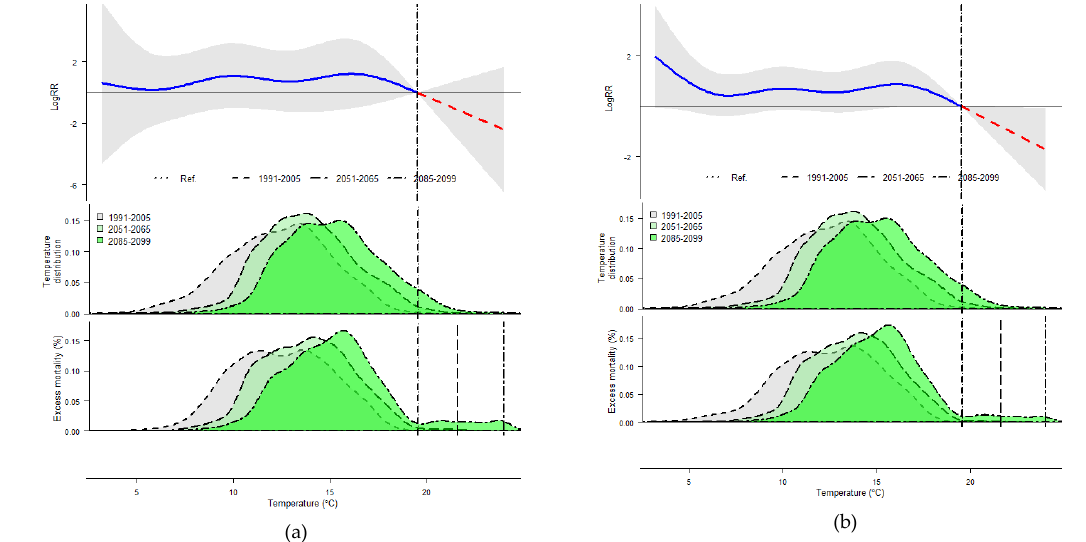
Figure 4. Temperature related mortality and excess mortality for the present and projected future periods in Lisbon metropolitan area (LMA) during the winter period for people aged <65 years ( a ) and 65+ years ( b ). Top panel: Exposure-response curve for temperature-mortality cumulative associations (logRR). The solid lines represent the logRR and the gray areas the 95% empirical confidence interval. The dotted vertical line corresponds to reference temperature (MMT) which divides the curve into cold and hot (blue and red lines, respectively). Middle panel: distribution of the temperature values for the present period, 1991–2005 (grey area), and future periods, 2051–2065 (green area) and 2085–2099 (darker green area). Bottom panel: distribution of temperature-related excess mortality, expressed as the fraction of additional deaths (%) attributed to non-optimal temperature compared with the reference temperature. Atmosphere 2020 , 11 , x FOR PEER REVIEW